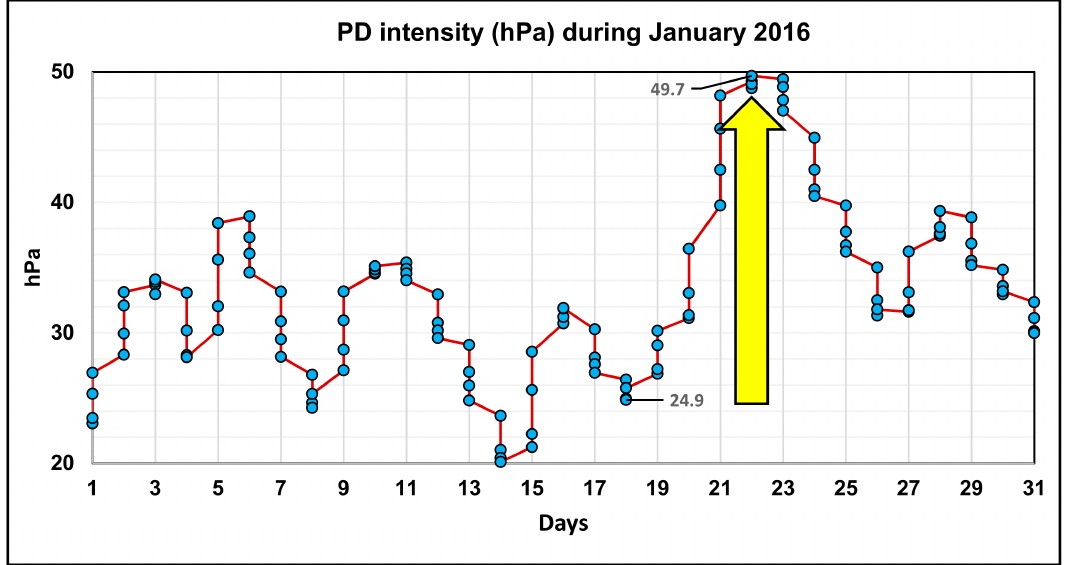
Figure 3. ERA-Interim pressure difference (PD; hPa) for January 2016 between the SH and Aleutian Low (AL) domains computed in 6-hourly intervals. Yellow arrow shows rising pressure difference (PD). Data from the ECMWF, ERA-Interim.